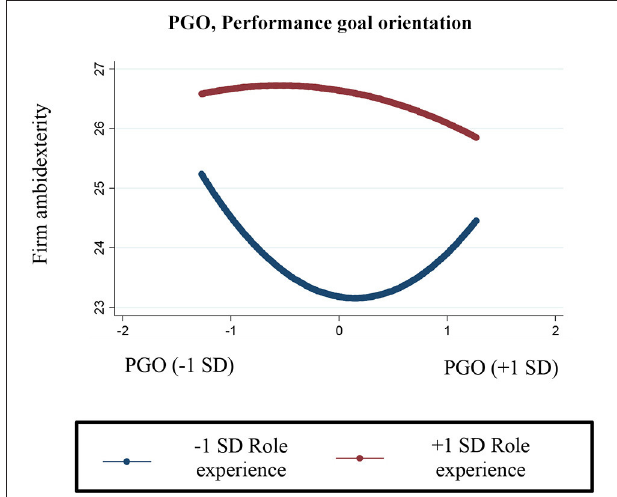
FIGURE 3 | Interaction of top decision makers’ performance goal orientation and role experience on firm ambidexterity.